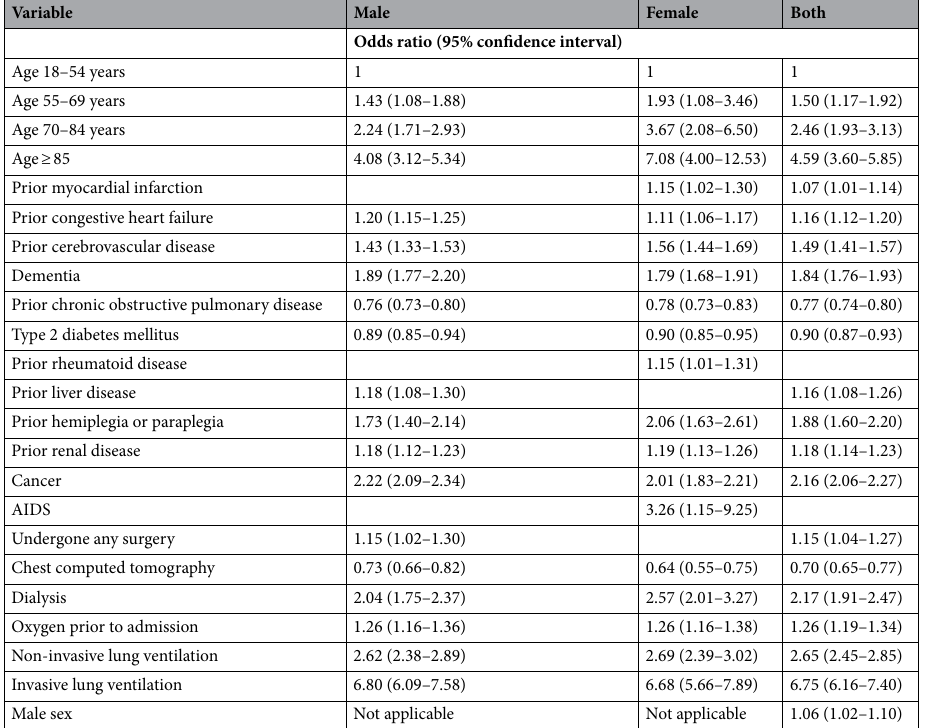
Table 6. Multivariable analysis of factors associated with in-hospital mortality during admission for community-acquired pneumonia among patients with atrial fibrillation prior to hospital admission, according to sex. Odds ratios indicate those variables significantly associated with in-hospital mortality. Blank spaces denote variables excluded in the final model.